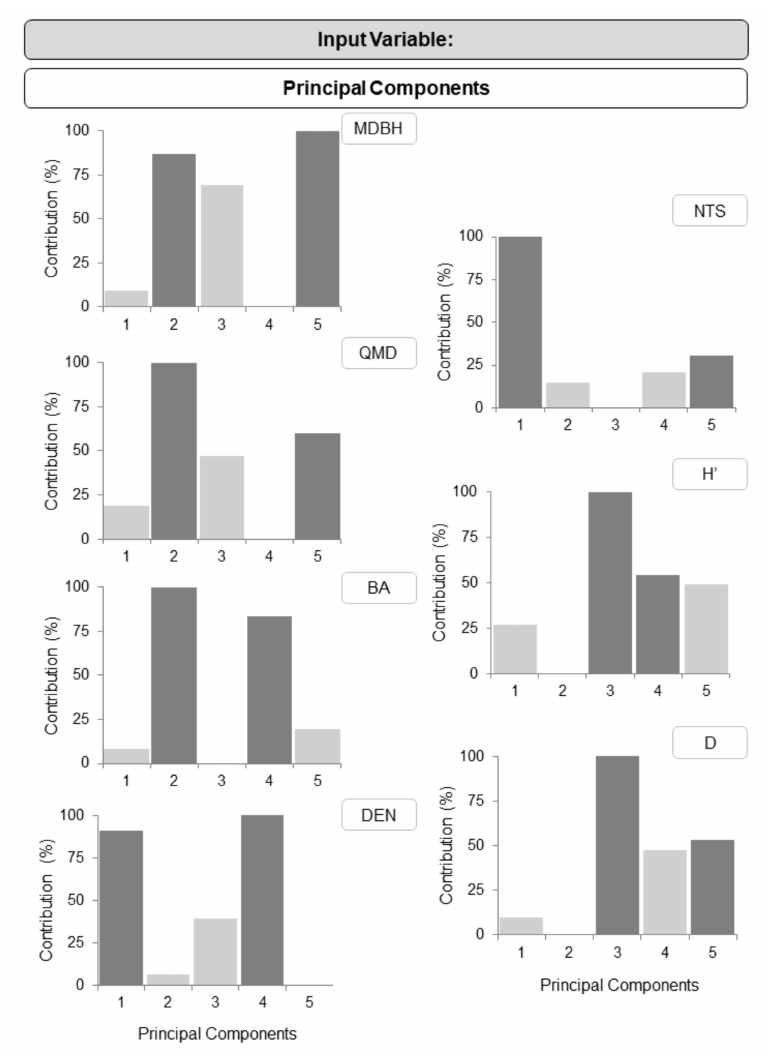
Figure 6. Relative importance of PCs for each forest variable modeled by the best-selected regres- sion